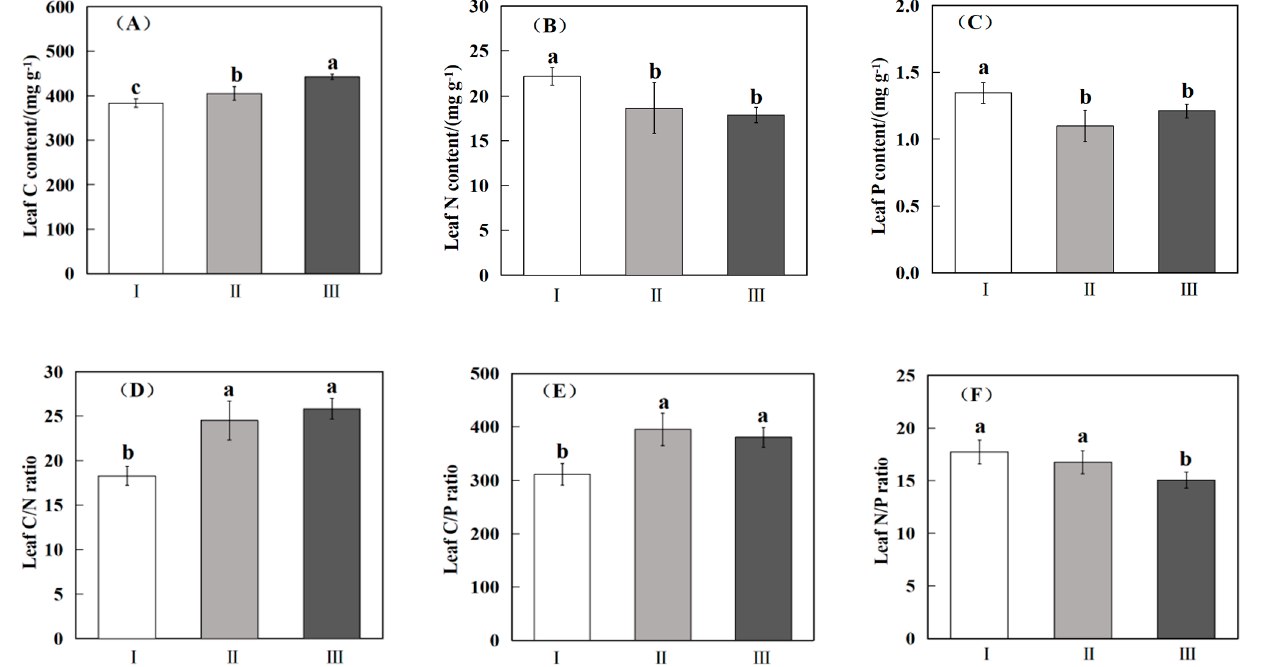
Figure 2. Comparison of leaf C, N, P content (A ‐ C) and ratio (D ‐ F) of different functional groups of desert saline shrubs. Note: I: euhalophyte; II: pseudohalophytes; III: secretohalophyte. Lowercase desert saline shrubs. Note: I: euhalophyte; II : pseudohalophytes; III : secretohalophyte. Lowercase letters indicate significant differences between plants ( p < letters indicate significant differences between plants ( p < 0.05).